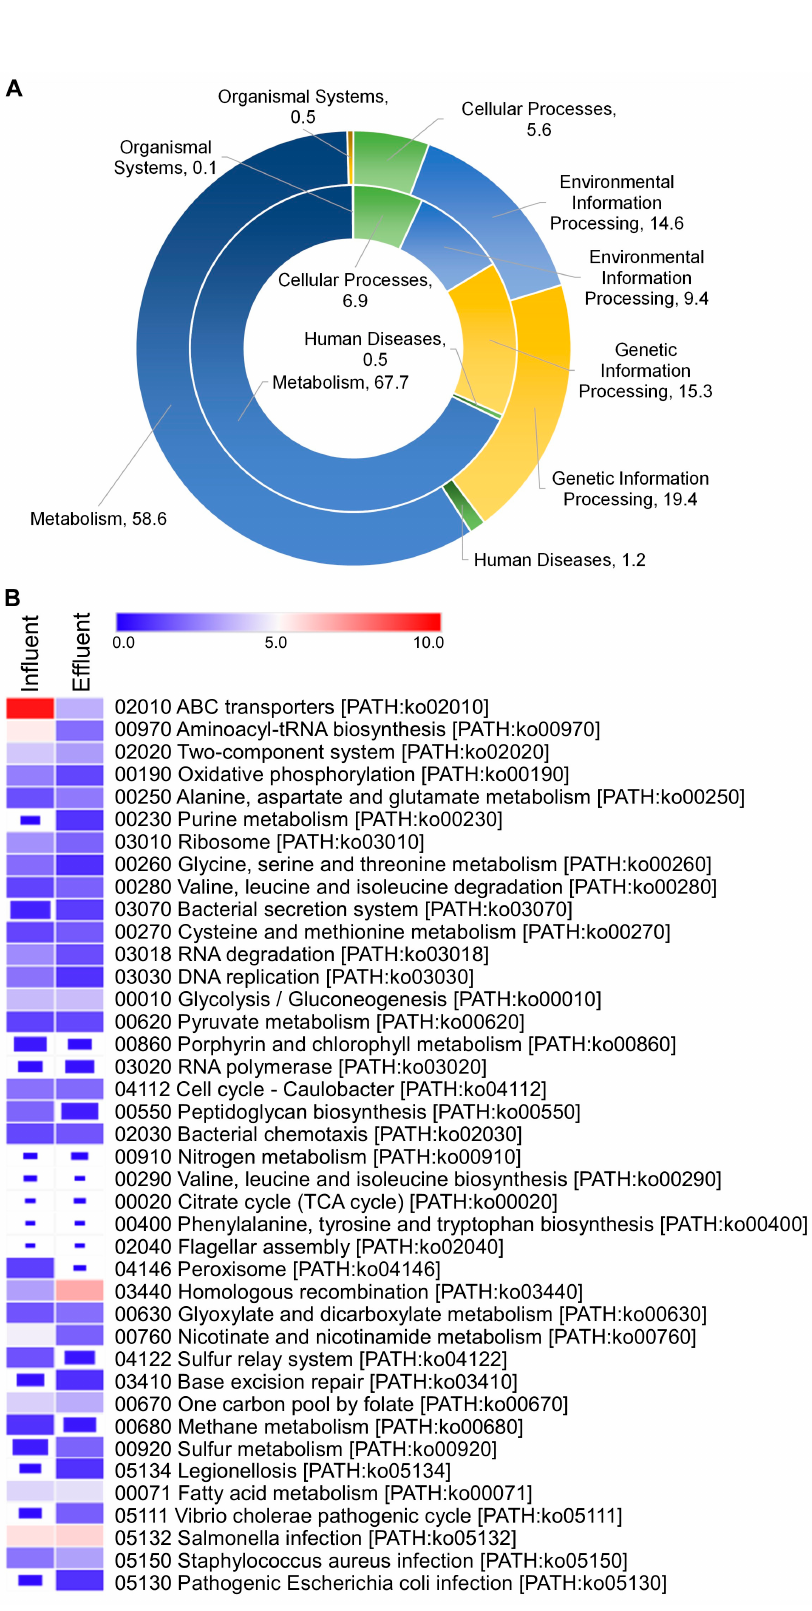
Figure 6. Functional analysis of the influent and effluent metagenomes. Percentage relative abun- dance of the dominant pathways identified by KEGG Orthology mapping. ( A ) Abundance of the dominant pathways at level 1. Inner ring represents influent and outer ring represent effluent ( B ) Abundance of the dominant pathways identified at sub-level. The size and color shade of the rectangle boxes are proportional to the relative abundance of the